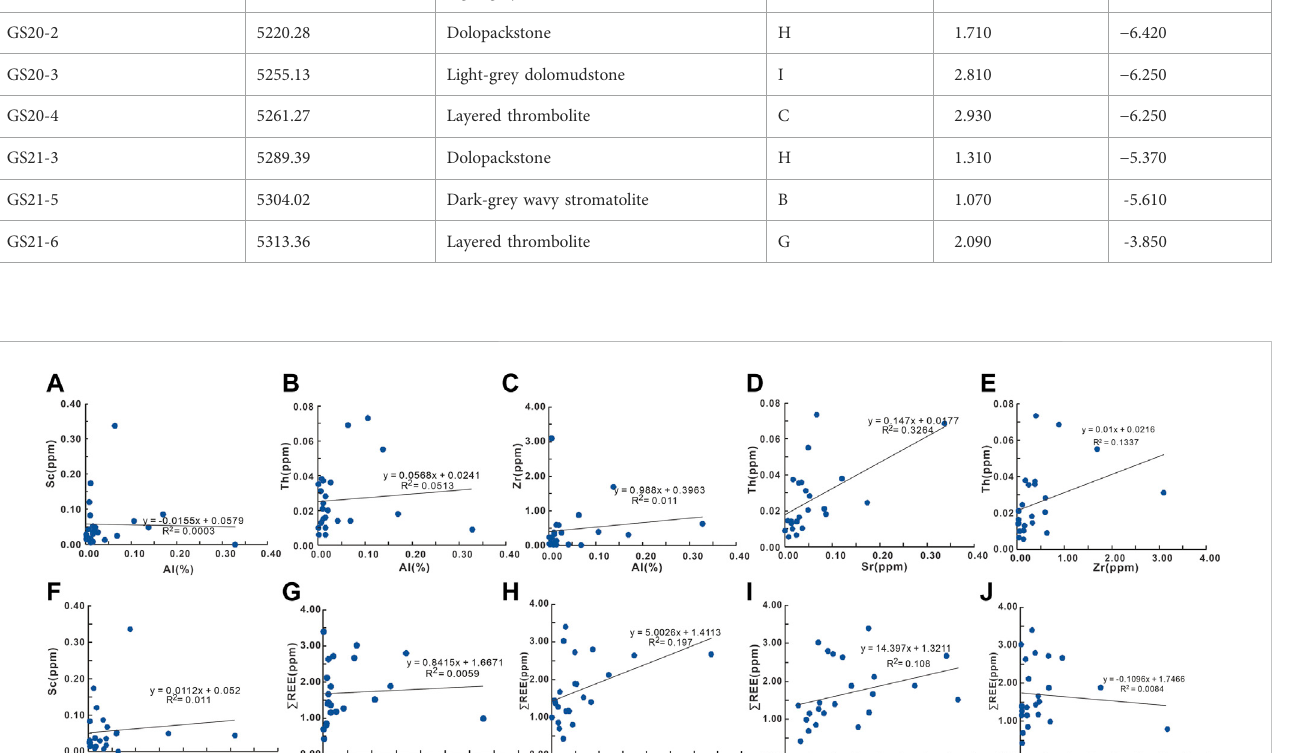
paleo-salinity (Keith and Weber, 1964). The δ 13 C values of platform margin lithofacies associations are between 0.680 ‰ and 2.610 ‰ (mean value = 1.940 ‰ ), while those of platform interior lithofacies associations are between − 0.860 ‰ and 3.150 ‰ (mean value = 1.517 ‰ ) (Figure 11C). The δ 18 O values of platform margin lithofacies associations range from − 8.990 ‰